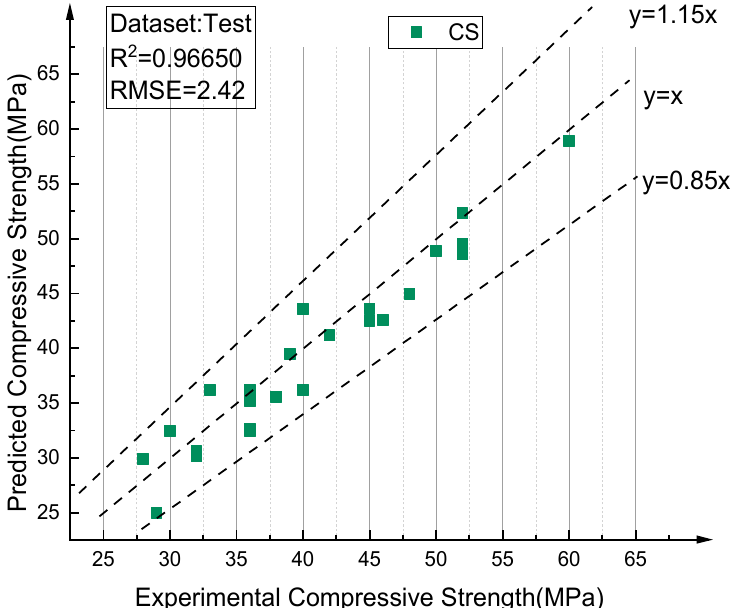
Figure 26. Comparison between prediction values and test values of RAC compressive strength (test data).